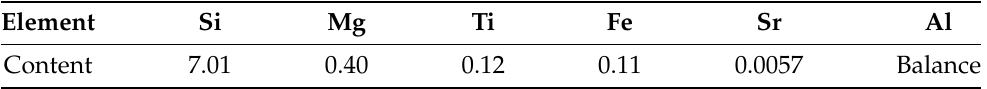
Table 1. The chemical composition of CPC A356 aluminum alloy (wt%).